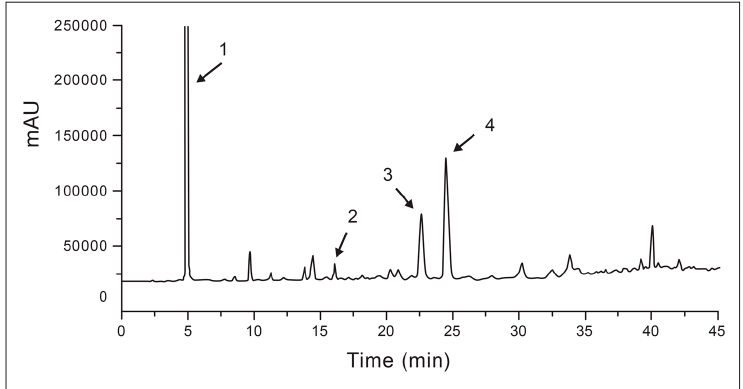
Figure 1. Chromatogram obtained by analyzing EtOAc phase of acetone extract of A. occidentale barks under optimized conditions of the analytical method. gallic acid (1); catechin (2); epicatechin (3); and epigallocatechin (4).